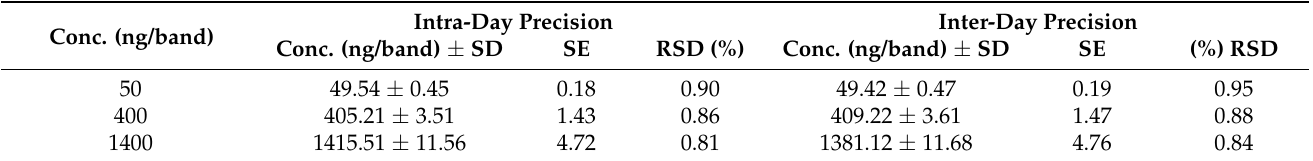
Table 3. Determination of FFA intra-day and inter-day precision for the ecofriendly HPTLC assay (mean ± SD; n = 6).